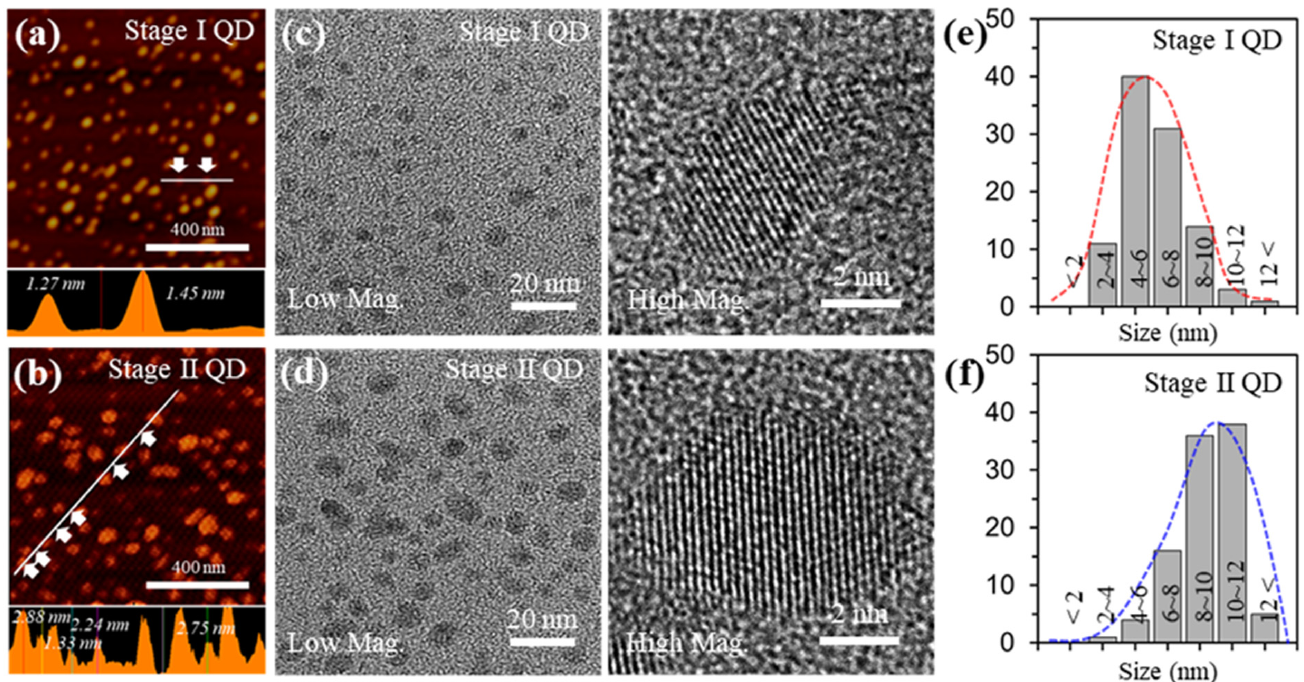
Figure 2. Characterizations for the GQDs with different sizes ( a , b ), AFM topology images (Top), and thickness profiles (bottom) of the GQDs. ( c , d ), TEM (Left) and HR-TEM (Right) images of the GQDs. ( e , f ), size distribution of the GQDs.